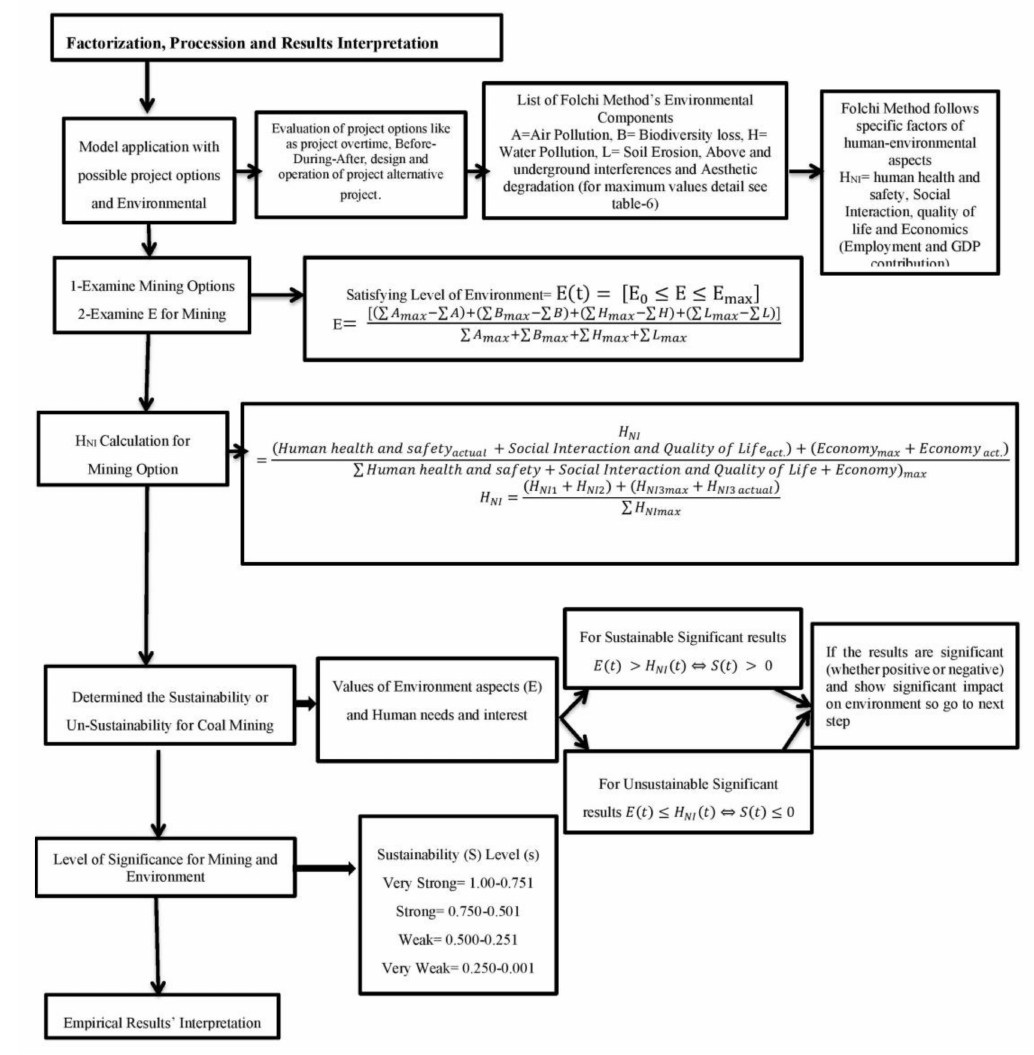
Figure 4. The successive steps of the Folchi Method for measuring environmental